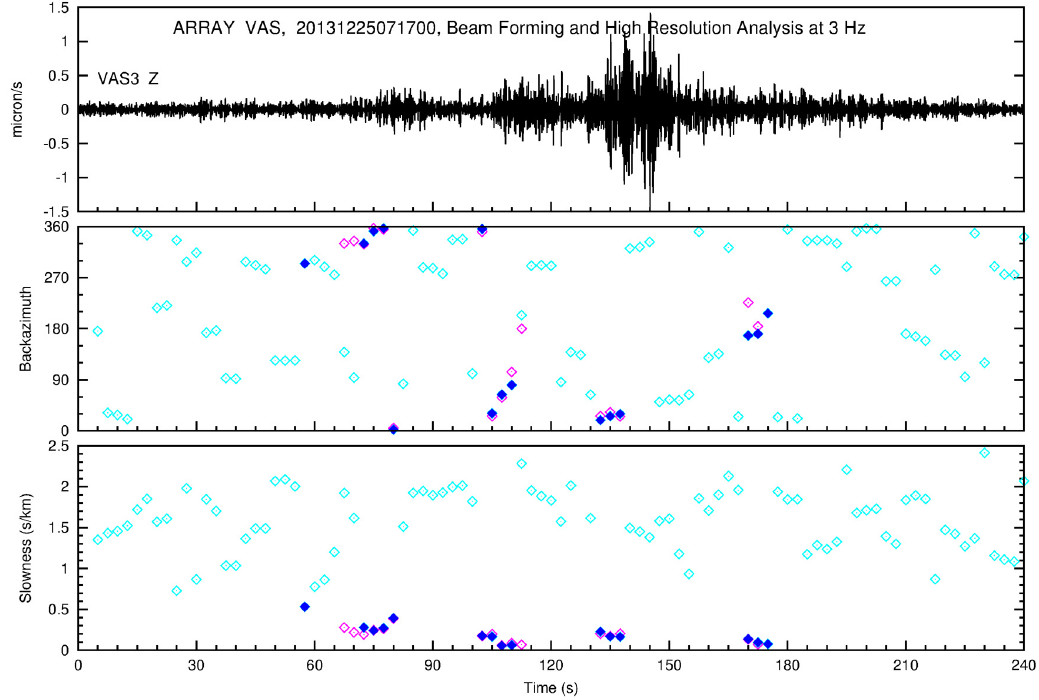
Figure 12. A short burst of volcanic tremor recorded by VAS array on December 25, 2013. The figure shows one vertical component seis- mogram (VAS3) bandpass filtered between 2 Hz and 4 Hz, backazimuth and slowness estimated by the array analysis focused at frequency of 3 Hz. Results of time windows with slowness smaller than 0.5 s/km are plotted by bold symbols for beam-forming (blue) and high-res- olution (magenta) to make more evident the body waves contribution to the recorded